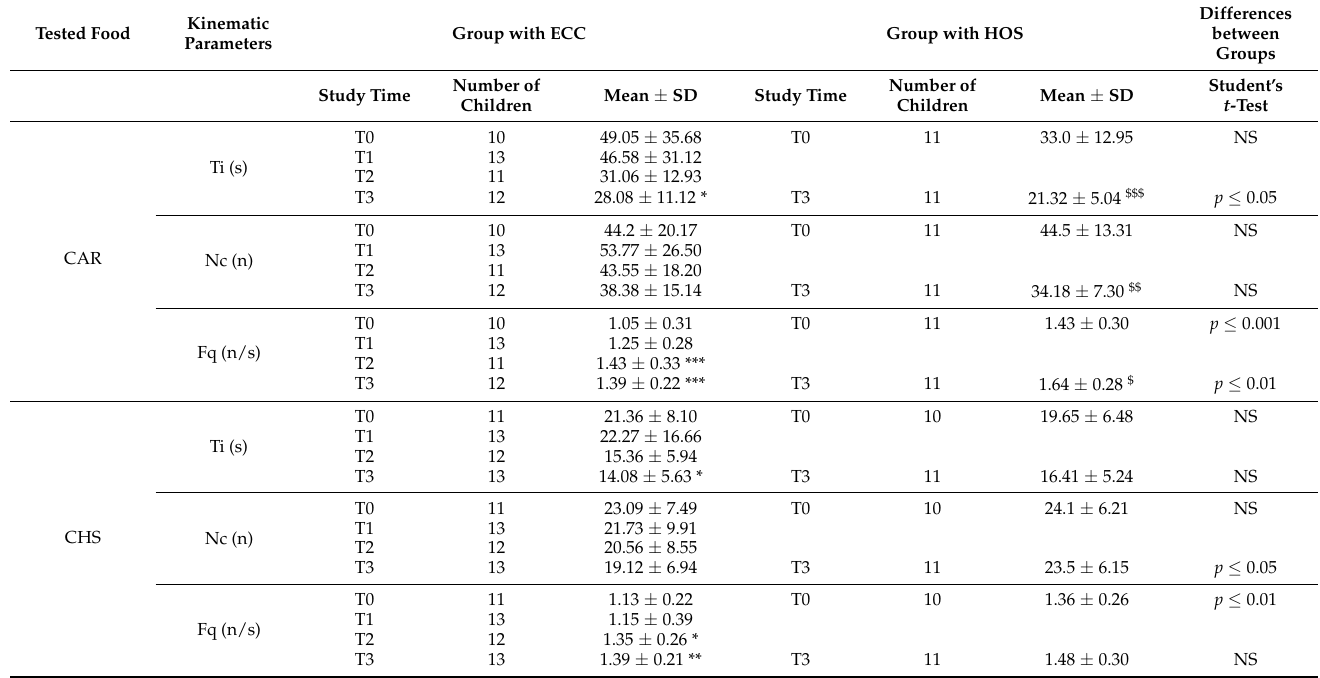
Table 4. Kinematic parameters according to evaluation times for both groups of